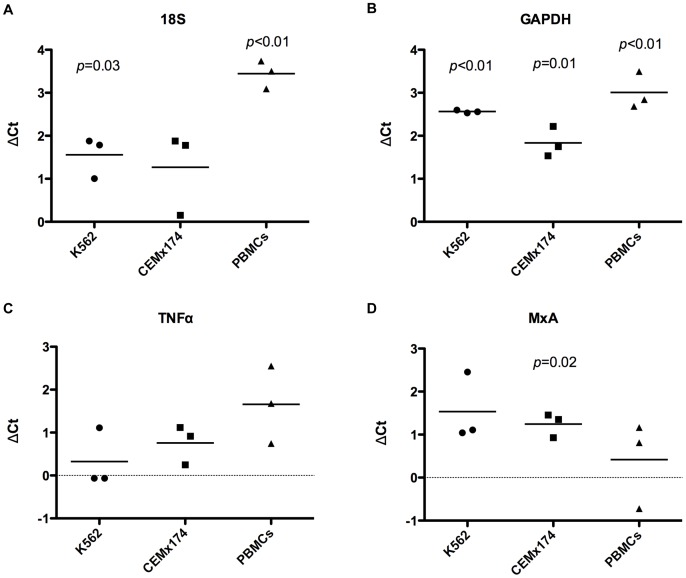
Comparison of mRNA quantitation by RT-qPCR between unfixed and fixed cells.18S (A), GAPDH (B), TNFα (C) and MxA (D) mRNA quantitation by RT-qPCR were compared between unfixed and fixed samples of two cell lines, K562 and CEMx174, and human PBMCs. Individual points represent the difference of Ct values between unfixed and fixed samples for each gene obtained from one experiment (ΔCt = Fixed Ct – Unfixed Ct). Three biological replicates are shown for each sample. p values were calculated by a one-sample, two-tailed t test comparing the average ΔCt to a theoretical mean set to zero. Statistically significant p values are shown.